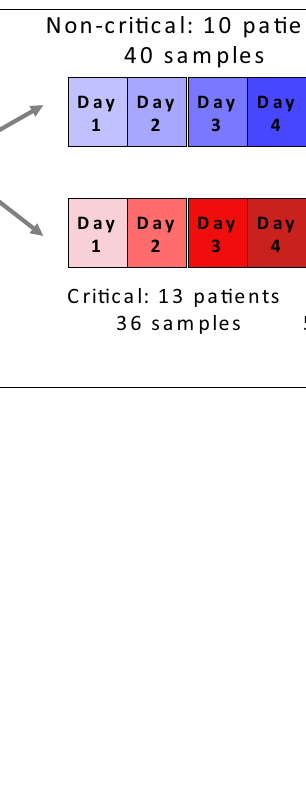
Figure 1. Study workflow: samples acquisition, proteome quantification and statistical analyses (figure created using R version 3.6.0, https:// www.R- proje ct. org/; and libreOffice version 6.4.7.2, https:// www. libre office.